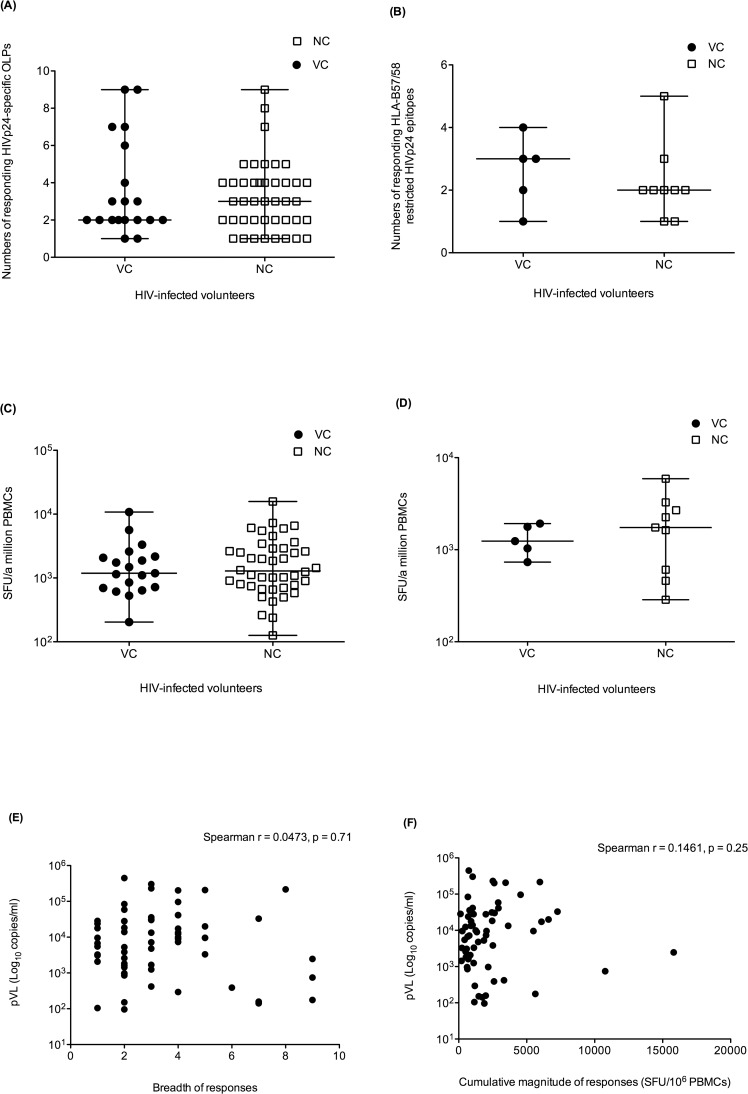
Measurements of IFNγ-producing cell responses using ELISpot assay.
(A) Breadth of T-cell responses against 23 HIVp24-specific OLPs from VC (N = 19, filled circle) and NC (N = 42, open rectangle) (B) Breadth of T-cell responses against HLA-B*57/B*58-restricted epitopes (N = 6) in HLA-B*57/B*58 positive VC (N = 5, filled circle) and NC (N = 9, open rectangle) (C) Cumulative magnitude of T-cell responses against 23 HIVp24-specific OLPs in VC (N = 19, filled circle) and NC (N = 42, open rectangle) (D) Cumulative magnitude of T-cell responses against HLA-B*57/B*58-restricted epitopes (N = 6) in HLA-B*57/B*58 positive VC (N = 5, filled circle) and NC (N = 9, open rectangle). (E and F) Correlation between breadth and cumulative magnitude of T-cell responses against HIVp24-specific OLPs and patient pVL were analyzed by using Spearman’s rank test.